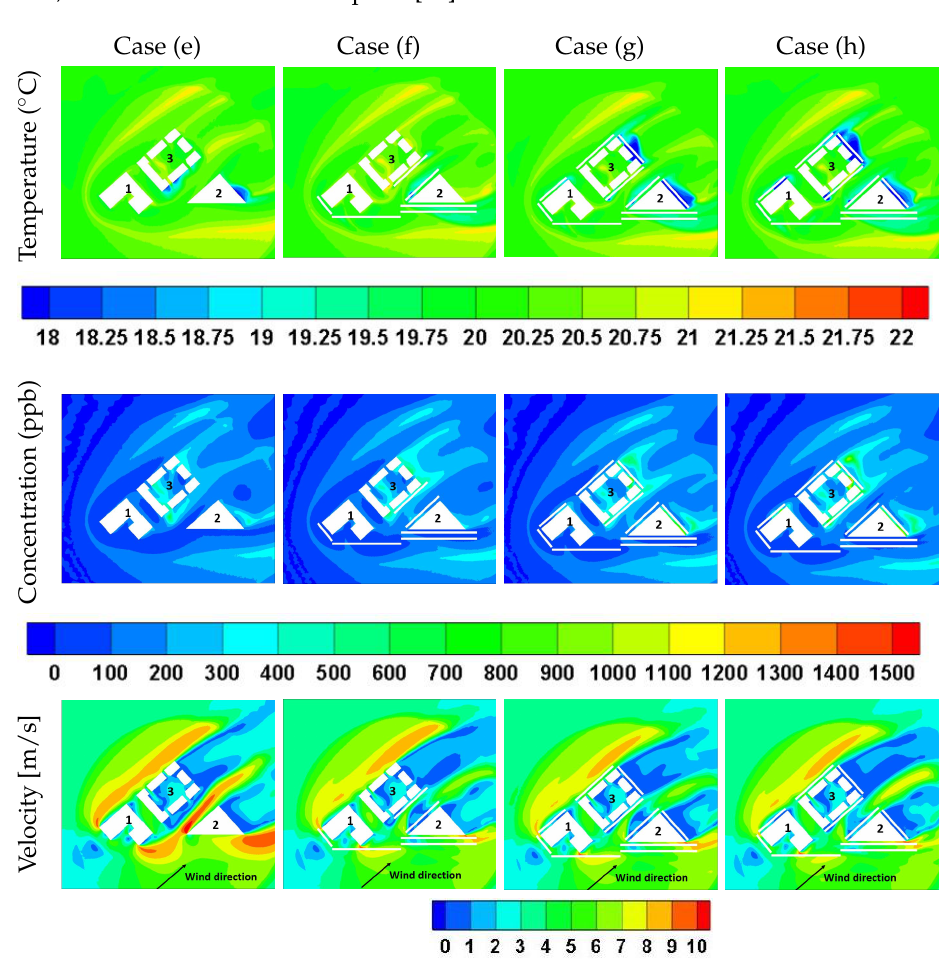
Figure 12. Contours of temperature, pollutant concentration and velocity at the pedestrian level for scenario 3 with a combination of: ( e ) green roofs and green walls; ( f ) green roofs and trees; ( g ) green roofs and more trees; ( h ) green roofs and trees with trees 2 m closer to the